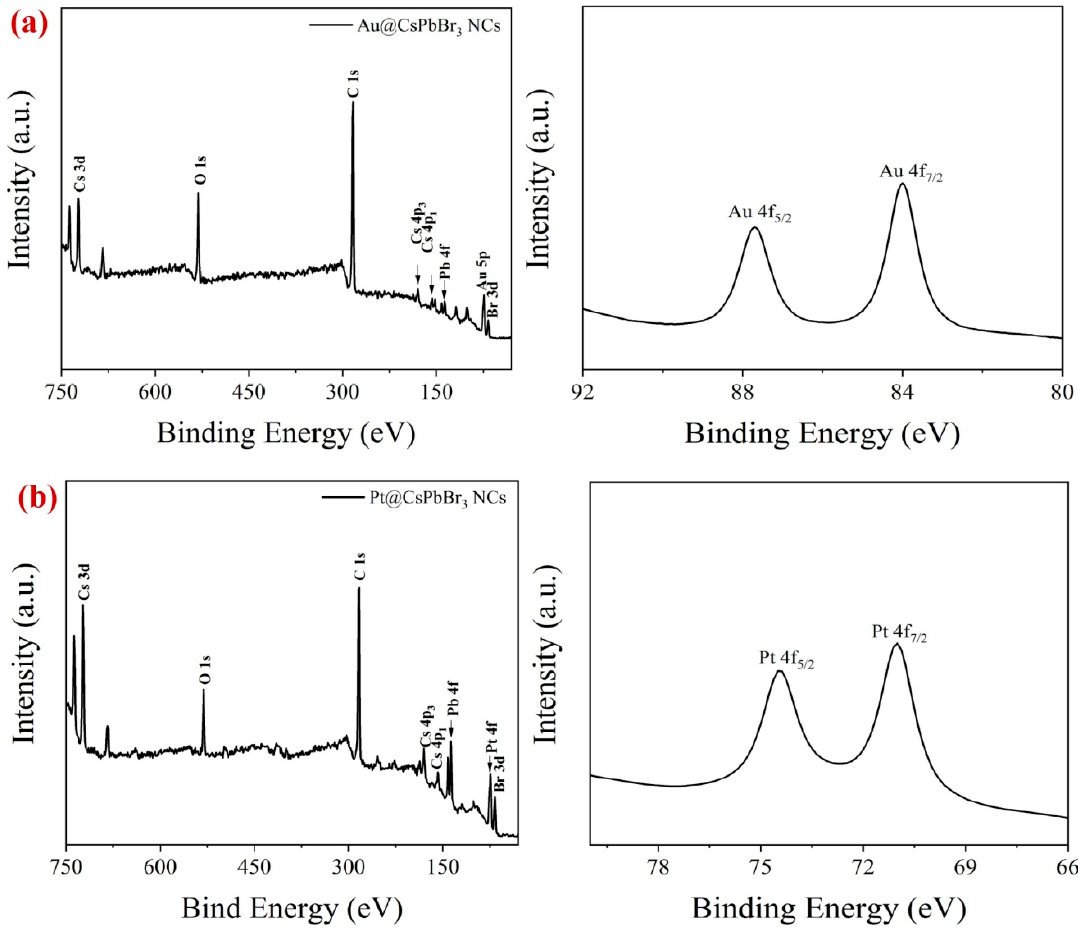
Figure 5. X-ray photoelectron spectroscopy (XPS) data of ( a ) Au@CsPbBr 3 and ( b ) Pt@CsPbBr 3 NCs.